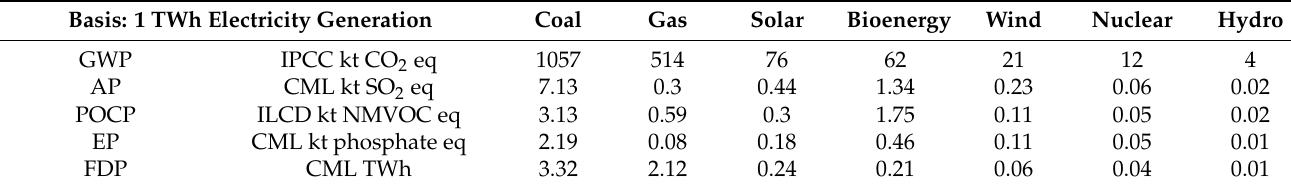
Table 4. The GWP (IPCC characterisation factors), acidification potential (AP), eutrophication potential (EP) and fossil depletion potential (FDP) (CML characterisation factors) and photochemical oxidant creation potential or urban smog (POCP) (ILCD characterisation factors) of coal, gas, solar, bioenergy, wind, nuclear and hydro electricity in the UK extracted from [28].